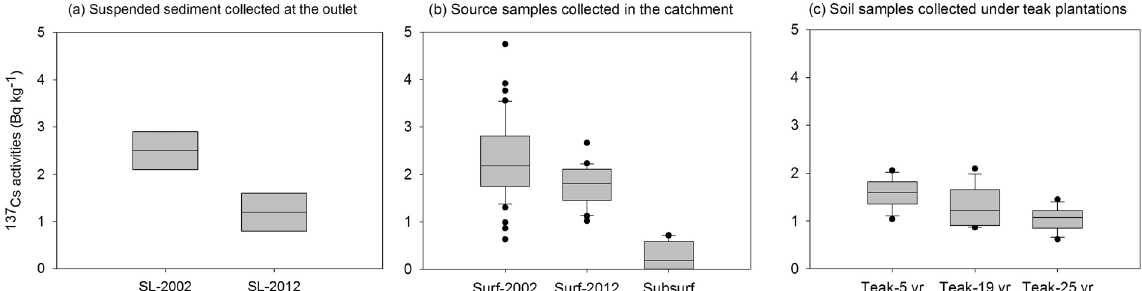
Figure 5. 137 Cs activities measured in ( a ) annual composite sediment samples in 2002 (SL-2002) and 2012 (SL-2012) at the catchment outlet (S4 monitoring station); ( b ) potential sources of sediment (surface of cultivated soils sampled between 2000–2005 [Surf-2002]; surface of cultivated soils sampled in 2012 [Surf- 2012]; subsurface samples collected in 2012 in gullies and channel banks [Subsurf]; ( c ) Surface soil under teak plantations of different maturity levels: 5-years old plantation [Teak-5 yr]; 19-years old plantation [Teak-19 yr];